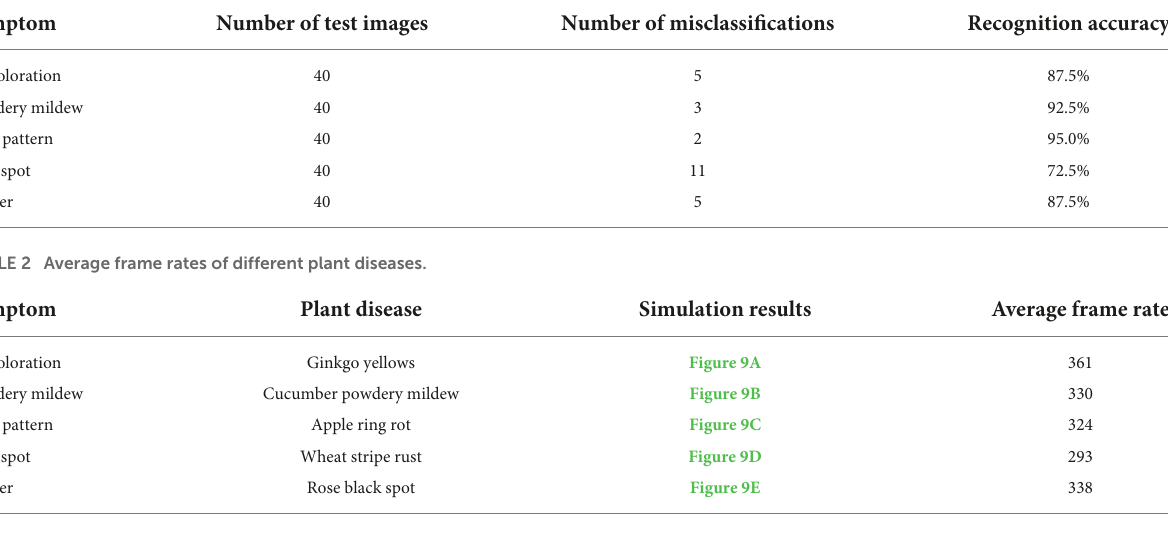
TABLE 1 Recognition accuracy of different disease symptom types.